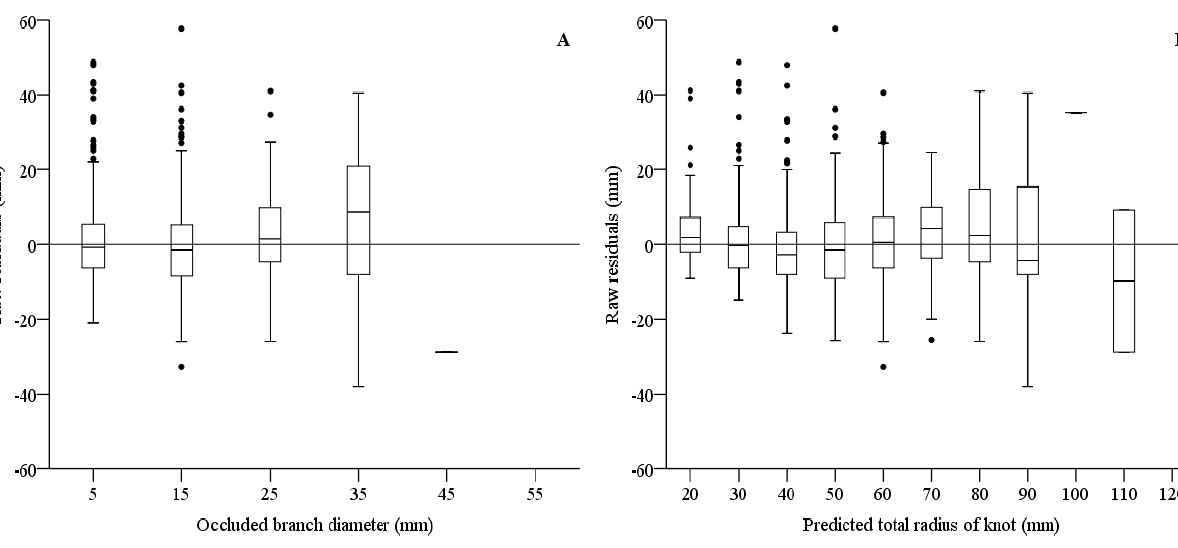
Figure 3. Raw residuals of the model on radius of dead portion of knot plotted against the independent variables ( A ) and predicted variables ( B ). The edges of the box are 25th and 75th percentiles; the vertical lines are drawn from the box to the most extreme point within 1.5 interquartile ranges; the transverse lines in boxes connect the medians.